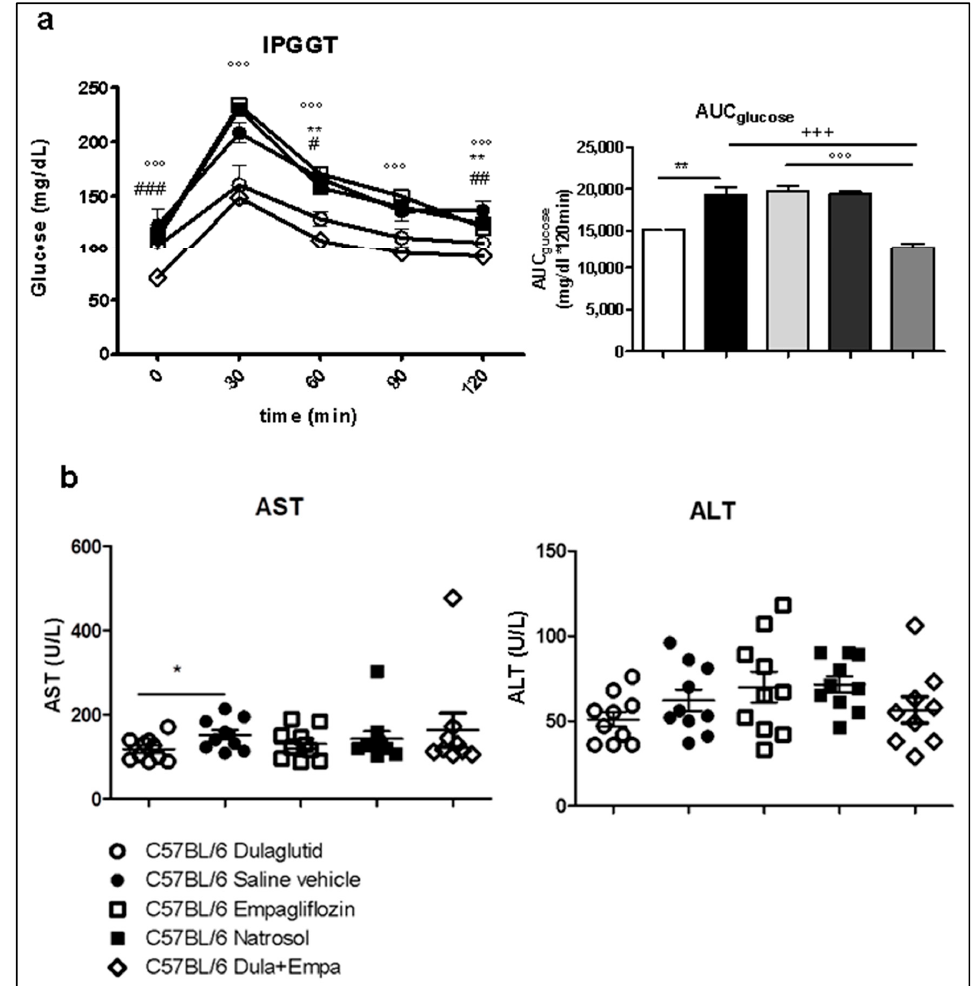
Figure 2. Metabolic parameters and transaminases ( a ) Intraperitoneal (i.p) glucose tolerance test. The trapezoidal rule was used to determine the area under the curve for glucose (AUC glucose). ( b ) Biochemical analyses of alanine (ALT) and aspartate (AST) transaminases in blood serum. Data are presented as mean ± SEM. Unpaired t -test with Welsh-correction was used for comparison between two groups. C57BL/6 Dulaglutide: n = 10, C57BL/6 Saline vehicle: n = 10, C57BL/6 Empagliflozin: n = 10, C57BL/6 Natrosol: n = 10; C57BL/6 Dula + Empa: n = 9; * p < 0.05; ** p < 0.01; *** p < 0.001 was used for comparison of Dulaglutide vs. Saline vehicle + p < 0.05; ++ p < 0.01; +++ p < 0.001 was used for comparison of Dula + Empa vs. Saline vehicle ◦ p < 0.05; ◦◦ p < 0.01; ◦◦◦ p < 0.001 was used for the comparison of Dula + Empa vs. Empagliflozin # p < 0.05, ## p < 0.01, ### p < 0.001 was used for comparison of Dulaglutide vs. Dula +